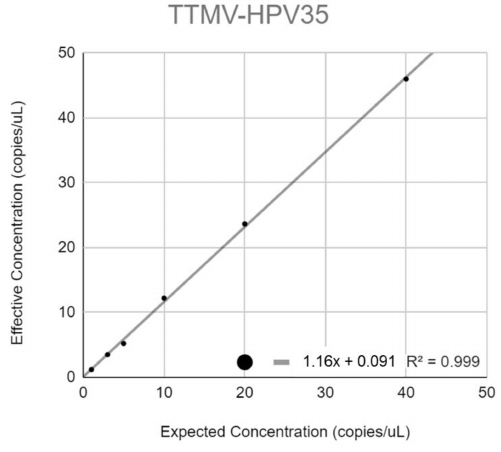
Figure A1. Linearity represented as expected-to-effective concentrations for TTMV-HPV16, 18, 31, 33 and 35 at 1–40 copies/ µ L, with respective equations and coefficients of determination.